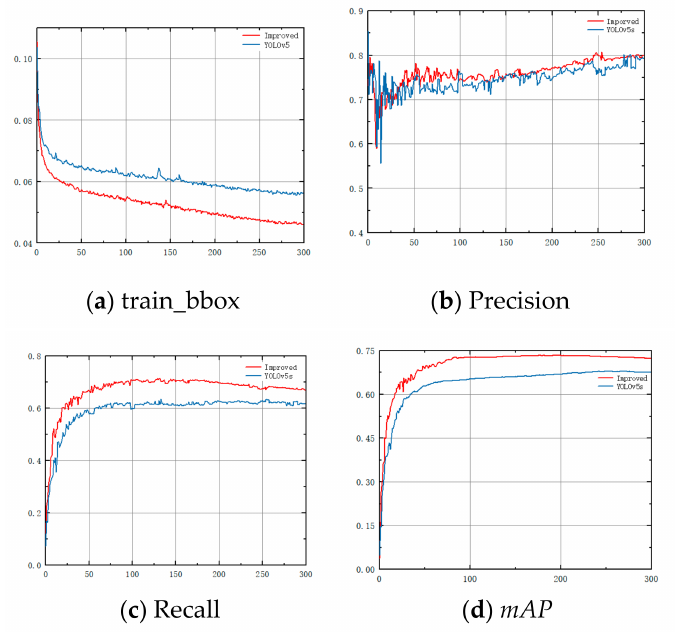
Figure 10. Training curve of this article and YOLOv5.